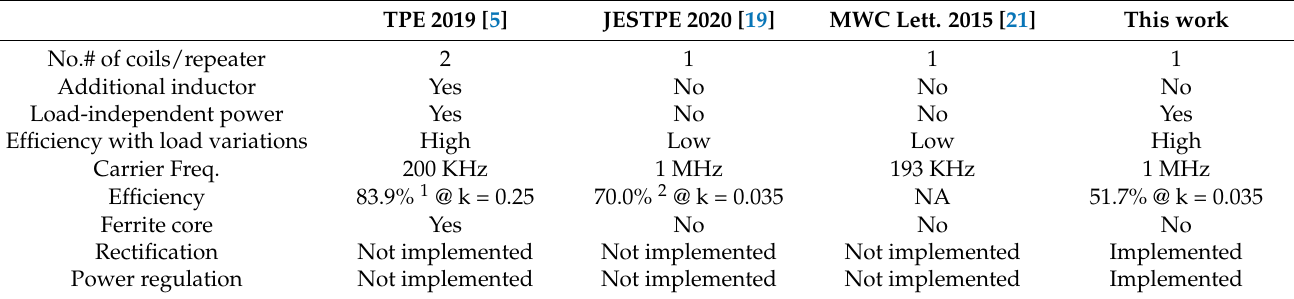
Table 1. Comparison with previous works.